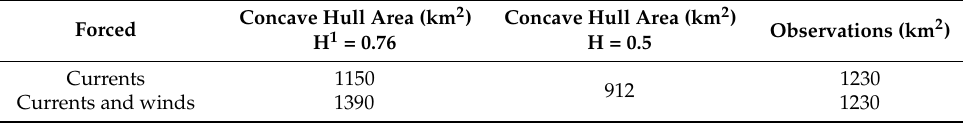
Figure 4. Comparison between the simulation results 53 hours after initial release and the observed data. The coefficient H is the Hurst value adopted in model runs. The yellow polygon is the initial red tide location ( on 2 July 2013 ), while the orange polygon is the observed data obtained on 4 July 2013 The red tide was regarded as 2000 particles (red circle points), and the blue arrows and black arrows show the direction and magnitude of current vector fields and the wind vector fields, respectively. Table 2. The red tide area comparisons between simulations and observations.